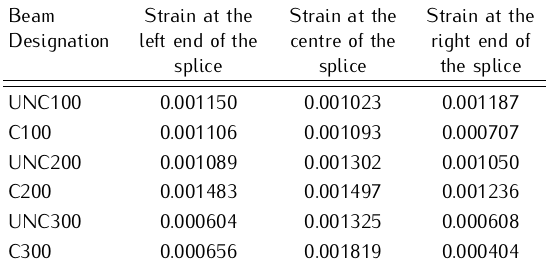
Table 6. Variation of strain along the